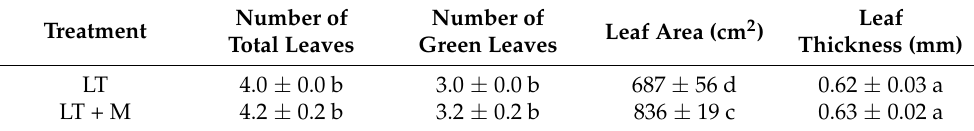
Table 1. Effects of wood vinegar on the growth of rapeseed seedlings under low-temperature stress. Treatment